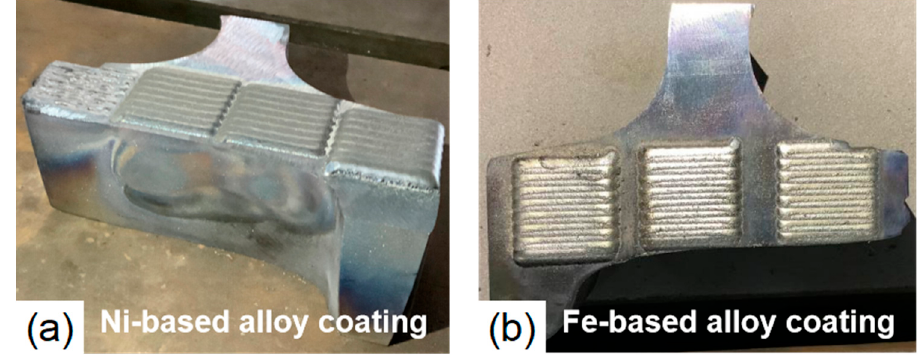
Figure 3. Samples of cladding.